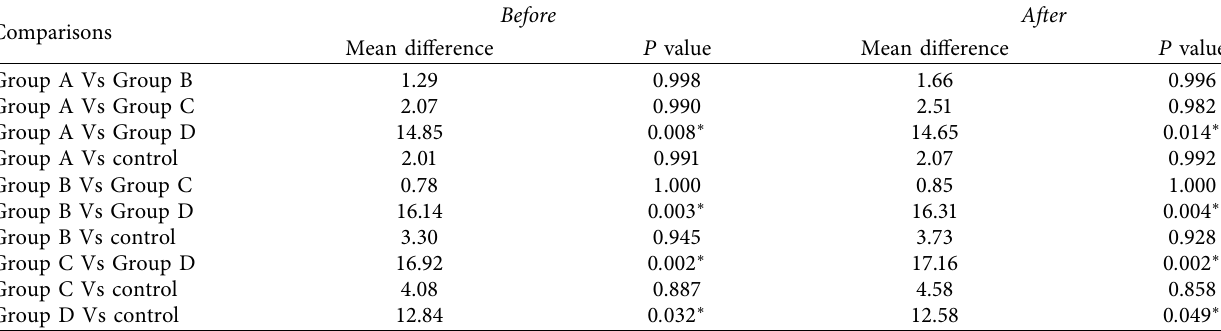
Table 6: Multiple comparison by Tukey Post Hoc test.